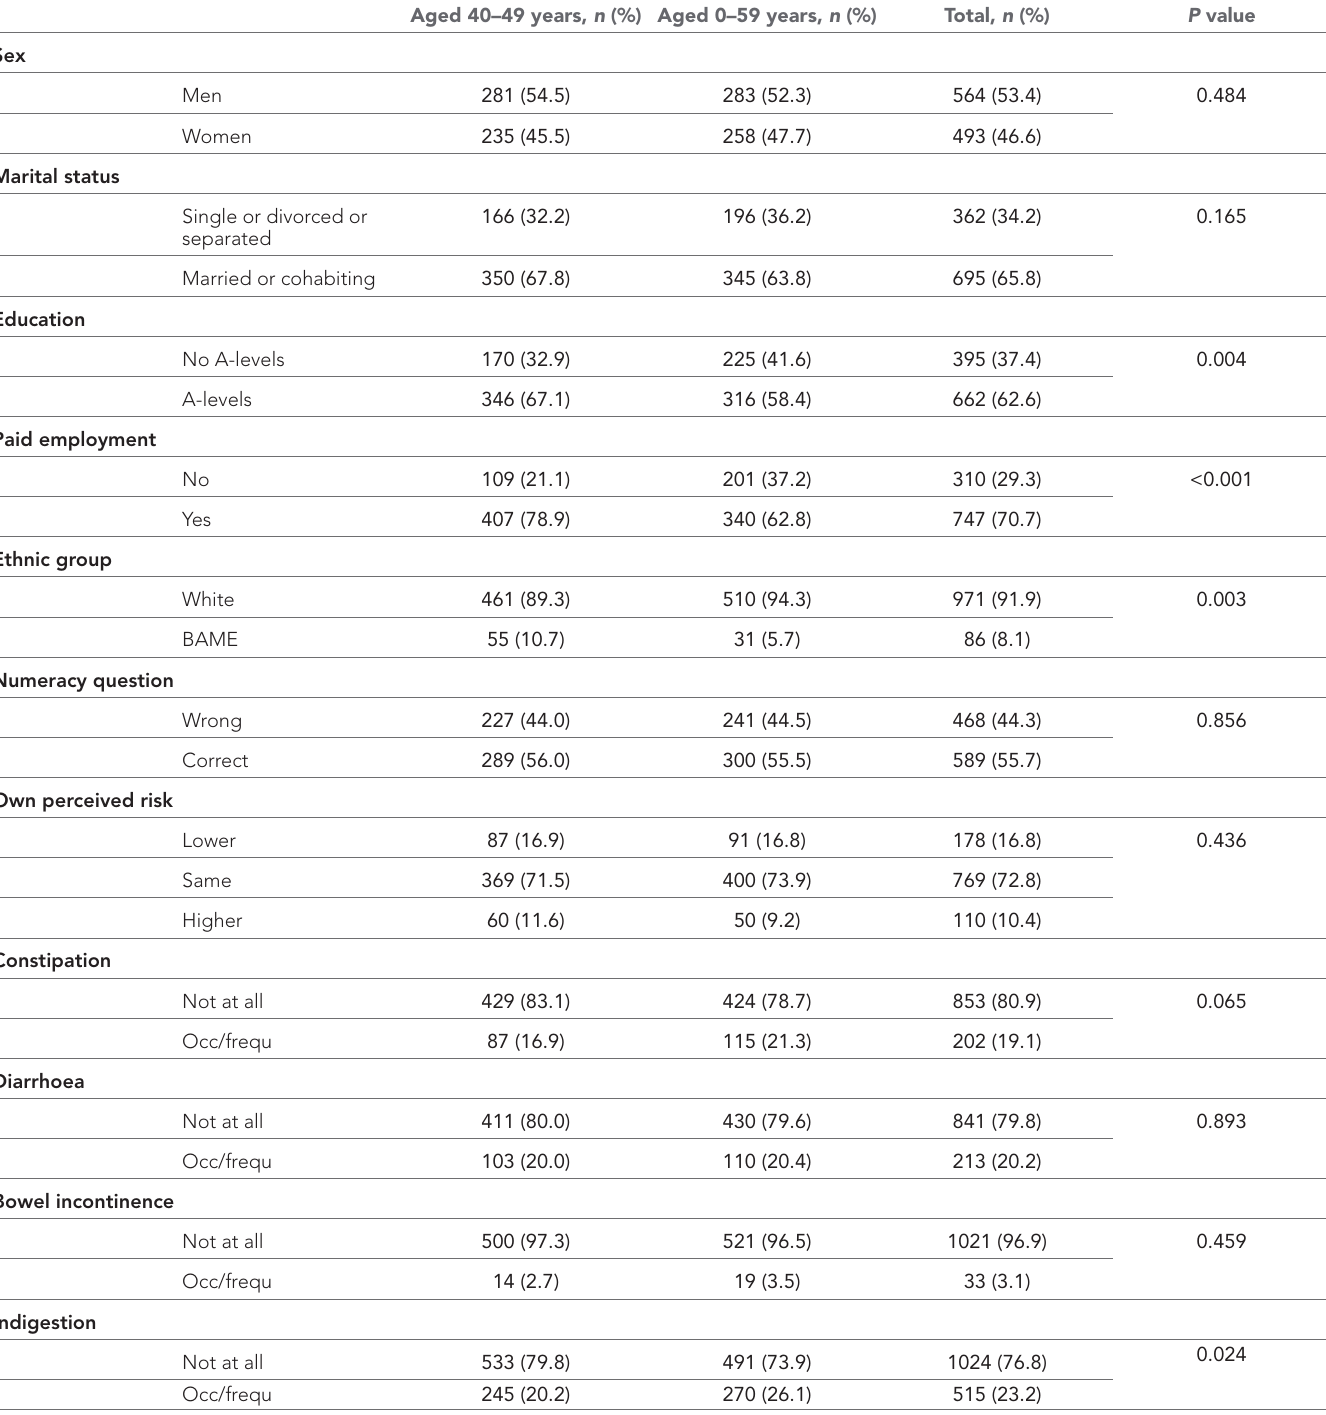
Table 1 Study sample‘s sociodemographic variables and symptoms in the last three weeks ( n =